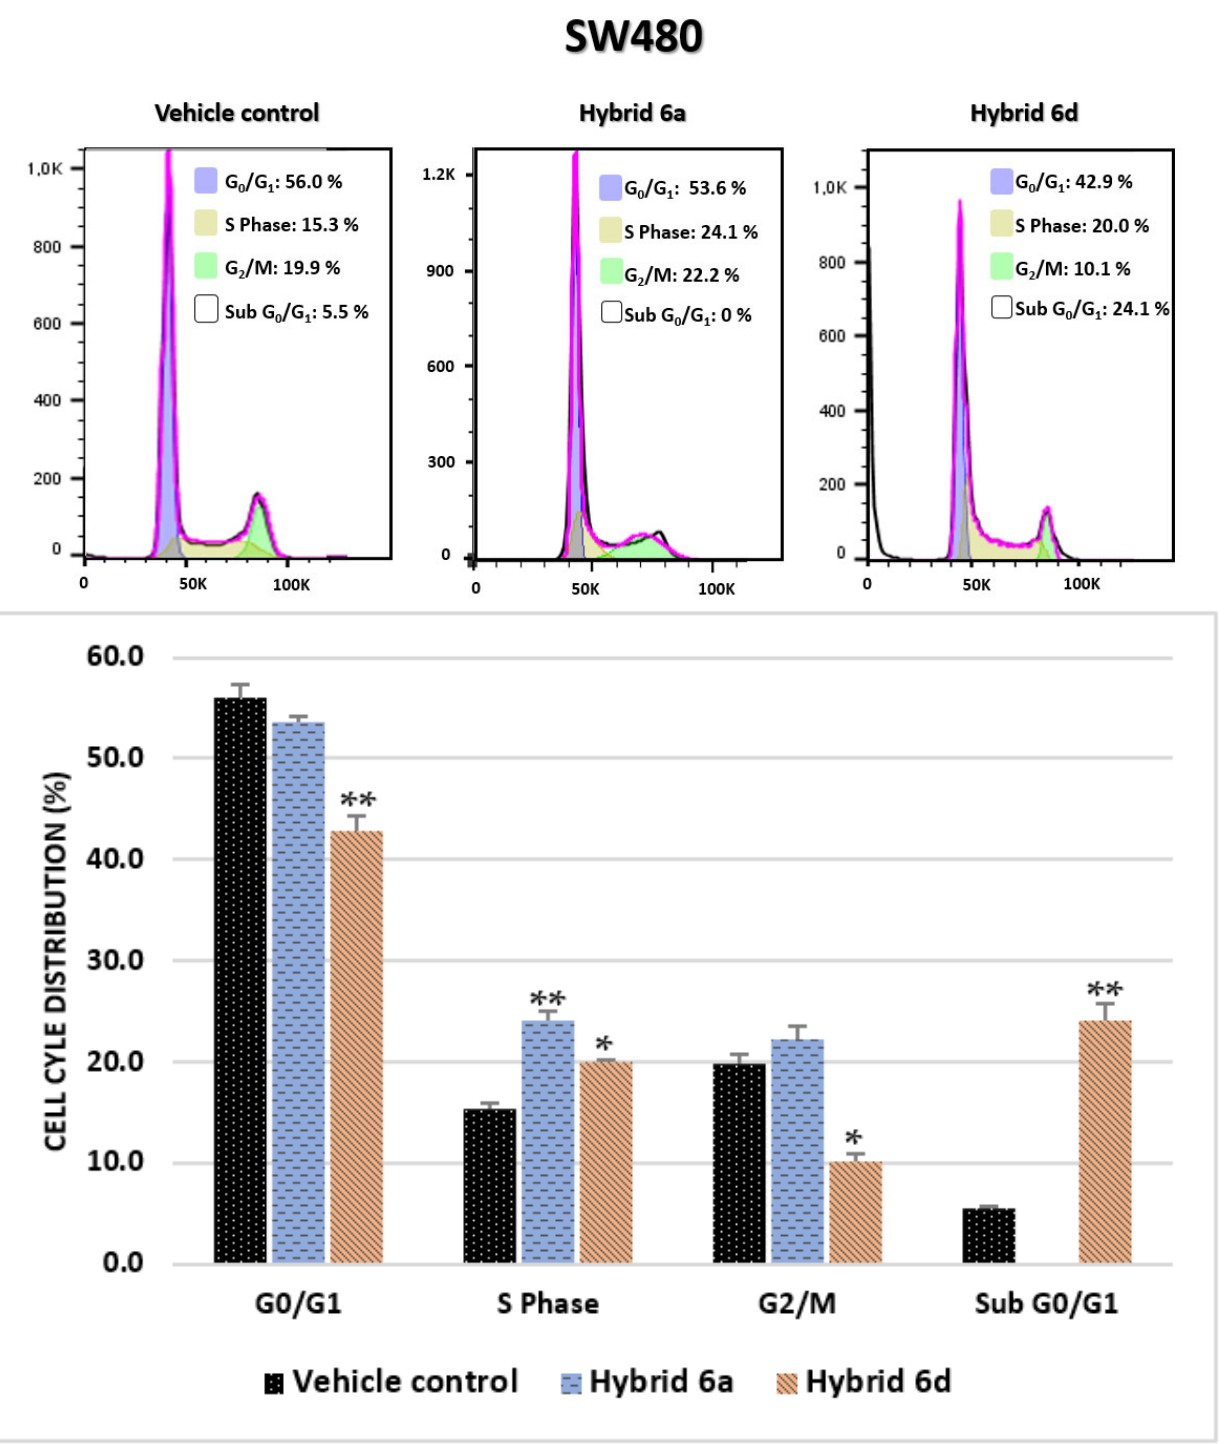
Figure 6. Cell cycle distribution after treatment with hybrids 6a and 6d in SW480 cells and repre- sentation of distribution percentages in bar chart form. All experiments were performed in duplicate and showed similar results. p -values lower than 0.05 were considered statistically signi fi cant (* p < 0.05; ** p < 0.01).